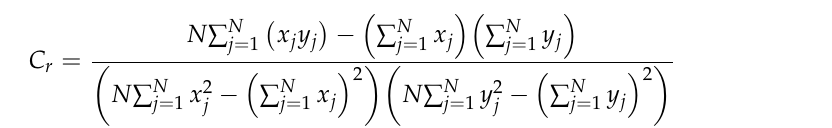
Figure 8. Histogram analysis. ( a ) Original Lena image histogram; ( b ) Encrypted Lena image histogram.